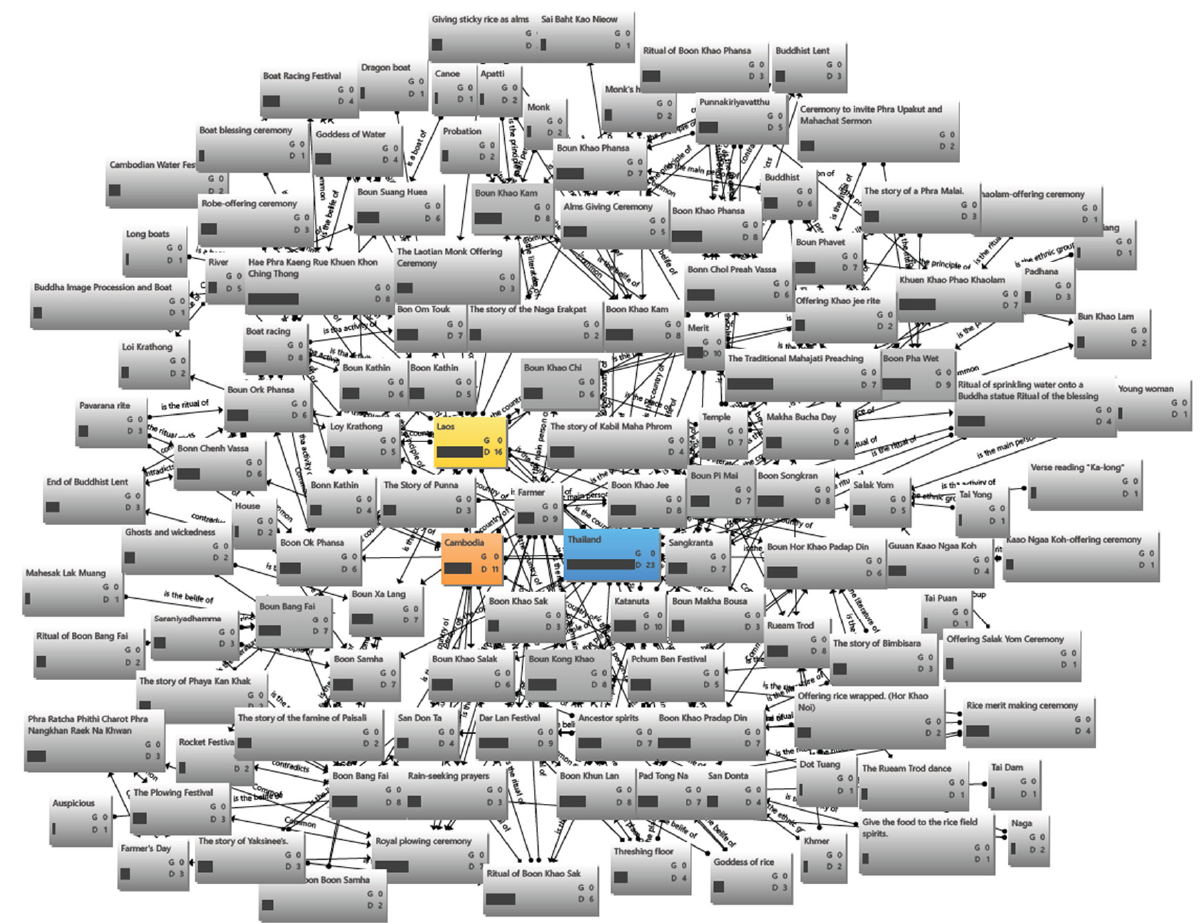
Figure 2. The systematic mapping of knowledge of the common culture of countries in the GMS.